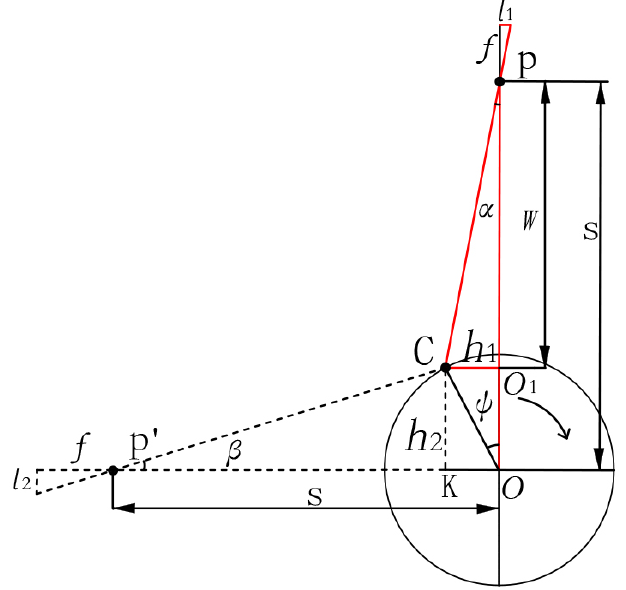
Figure 7. Schematic diagram of the pineapple eye depth information calculation.